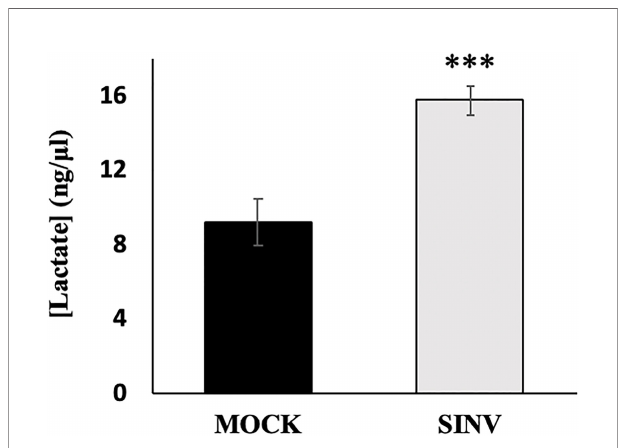
FIGURE 4 | Lacticacidaccumulationover24hourspostinfection.HEKcells infectedwithSindbisvirus(SINV)atanMOI=1hadsigni fi cantlyhigheraccumulationsof